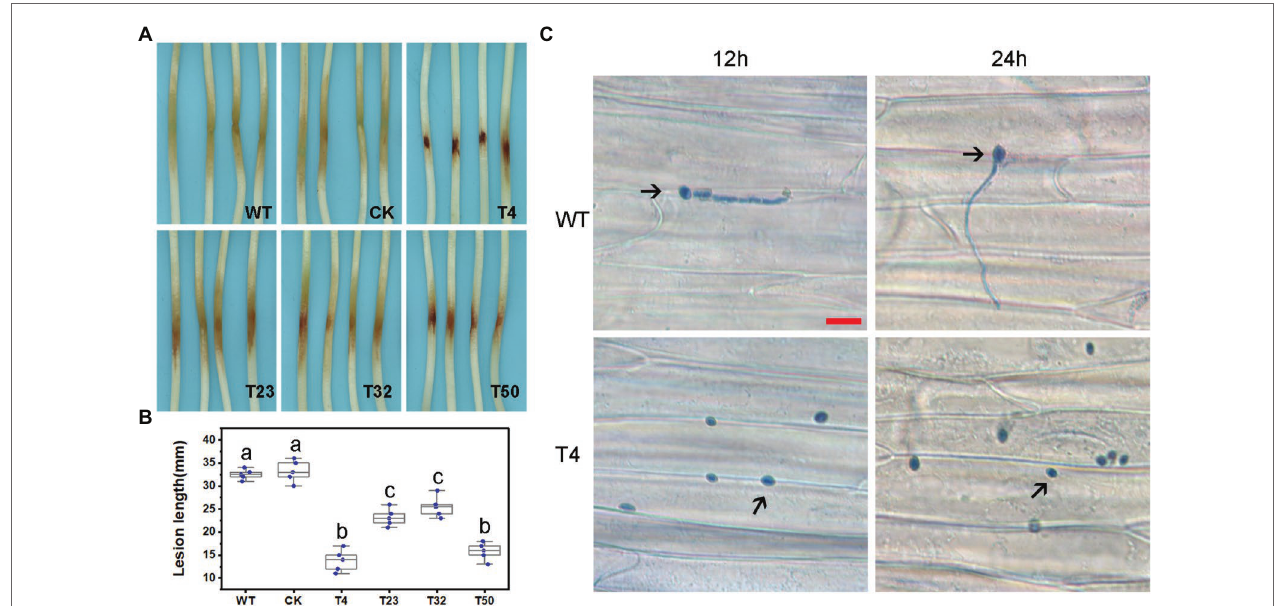
( Supplementary Figure S5D ). Morphological features of PsBTS1 mutants were examined and compared to the WT ( Figure 5 ). Compared to WT and CK strains, the mutants exhibited abnormal and smaller colonies ( Figure 5A